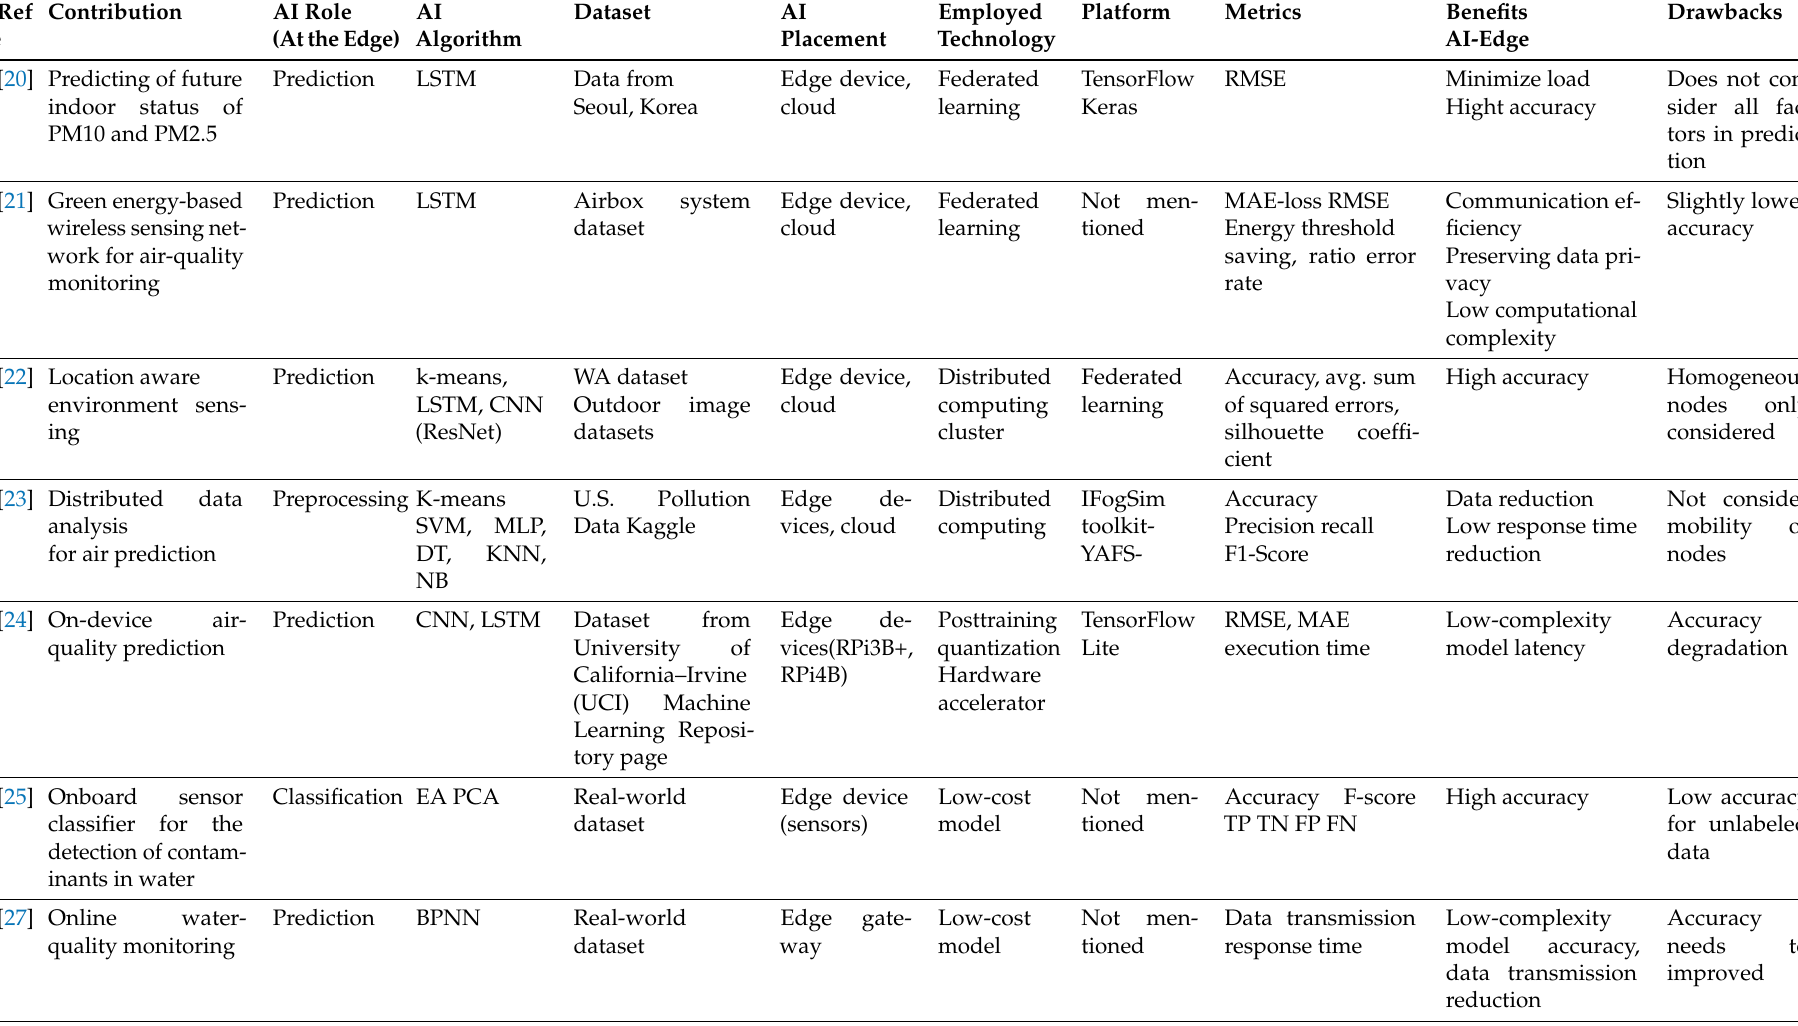
Table 3. Qualitative comparison of smart environment-related